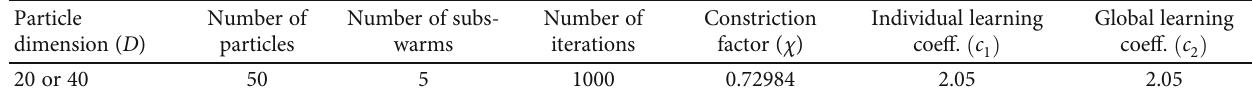
Table 4: PSO parameters.